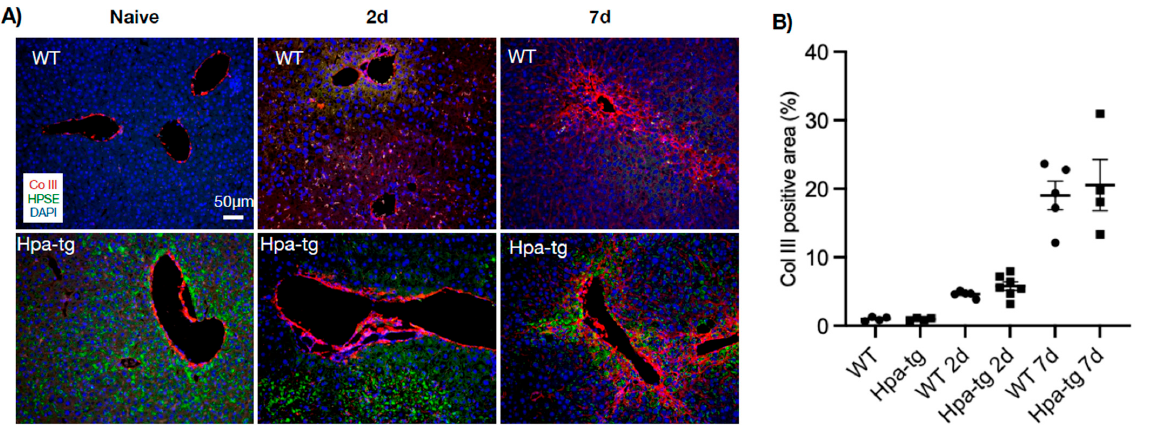
Figure 4. Immunohistostaining of collagen III (Col III, red) in paraffin-embedded liver sections. ( A ) In naïve mice, Col III was only detected along larger vessels. Upon CCL4 induction, the signals are intensified around veins and expanded to pericentral and periportal areas. ( B ) Col III -positive areas quantified by ImageJ. More than 10 random fields were quantified for each mouse ( n = 4–7 per group). Staining intensity measured in WT naïve group was set arbitrarily to a value of 1. Heparanase (HPSE, green) was detected only in the Hpa-tg liver.